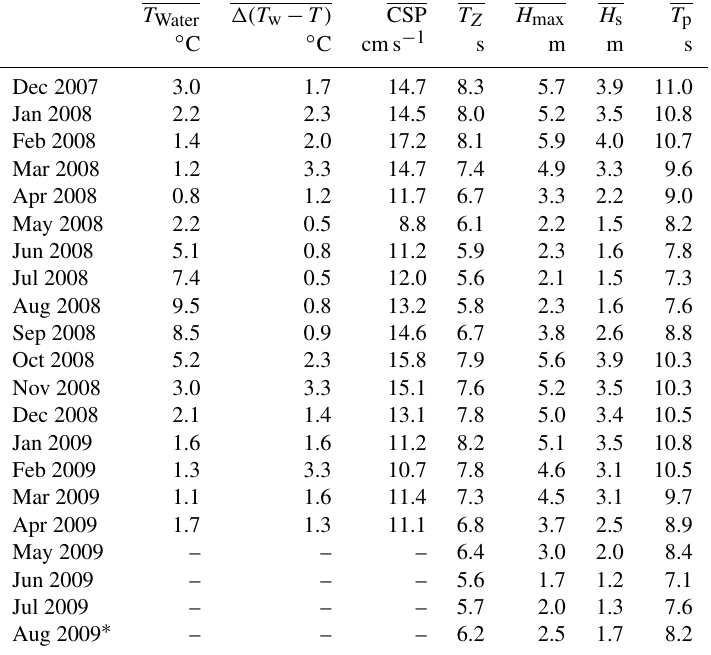
Table 5. Monthly average values for a few of the oceanographic parameters: water temperature, current speed, mean wave period, height of highest wave, significant wave height and period of spectral peak. The parameter (cid:49) ( T w − T ) is the monthly averaged difference between the water temperature and the air temperature. Insufficient data is represented with −